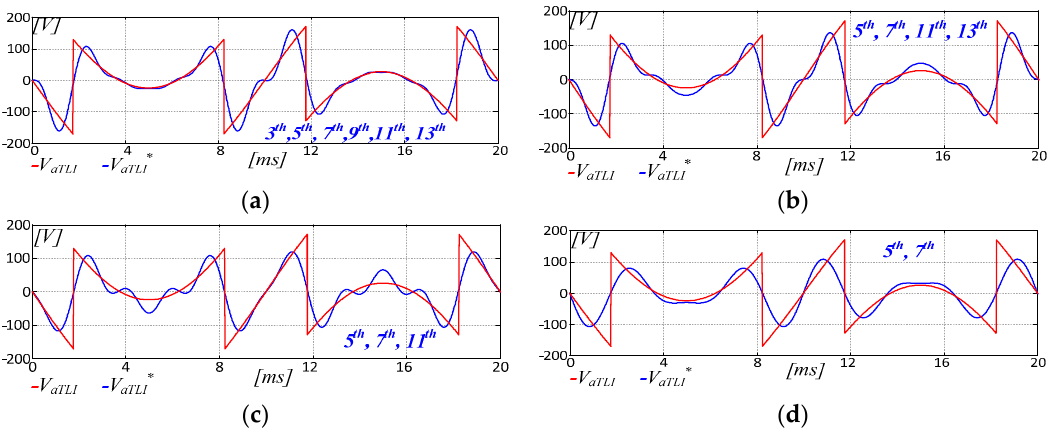
Figure 8. TLI reference voltage approximation. ( a ) 3 rd , 5 th , 7 th , 9 th , 11 th , 13 th . ( b ) 5 th , 7 th , 11 th , 13 th . ( c ) 5 th , 7 th , 11 th . ( d ) 5 th , 7 th .